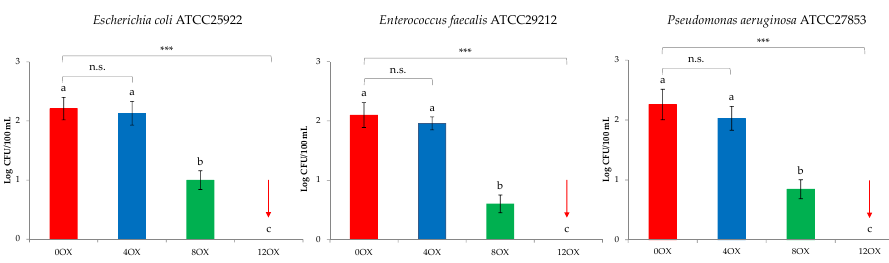
Figure 2. Counts of water-borne pathogenic bacteria in food ice activated with different concentra- tions of H 2 O 2 . p value: *** p < 0.001; n.s.—not significant. The letters a, b, and c on the histograms indicate difference between the samples analyzed according to Tukey’s test.